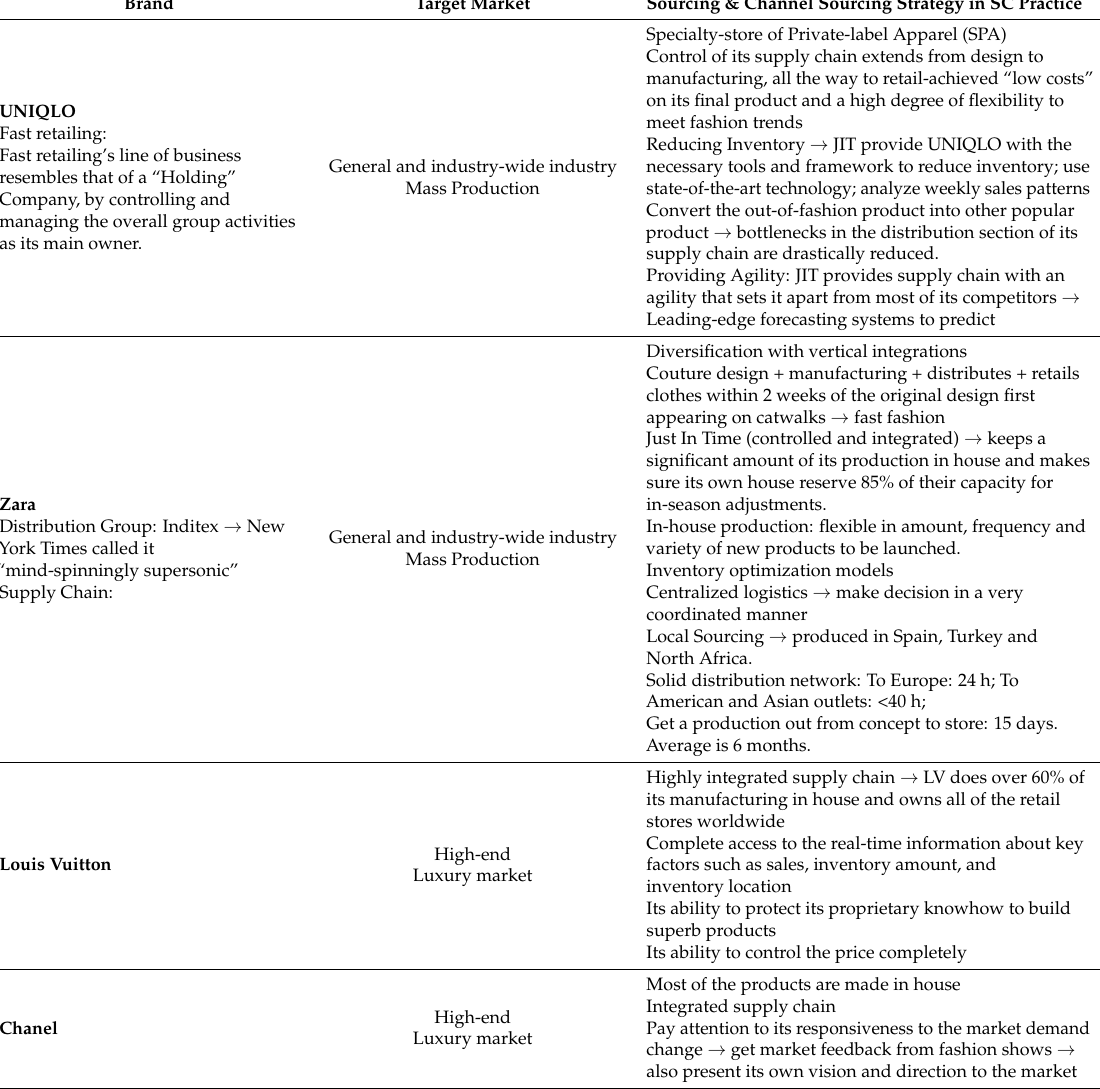
Table 2. Summary of Supply Chain Management